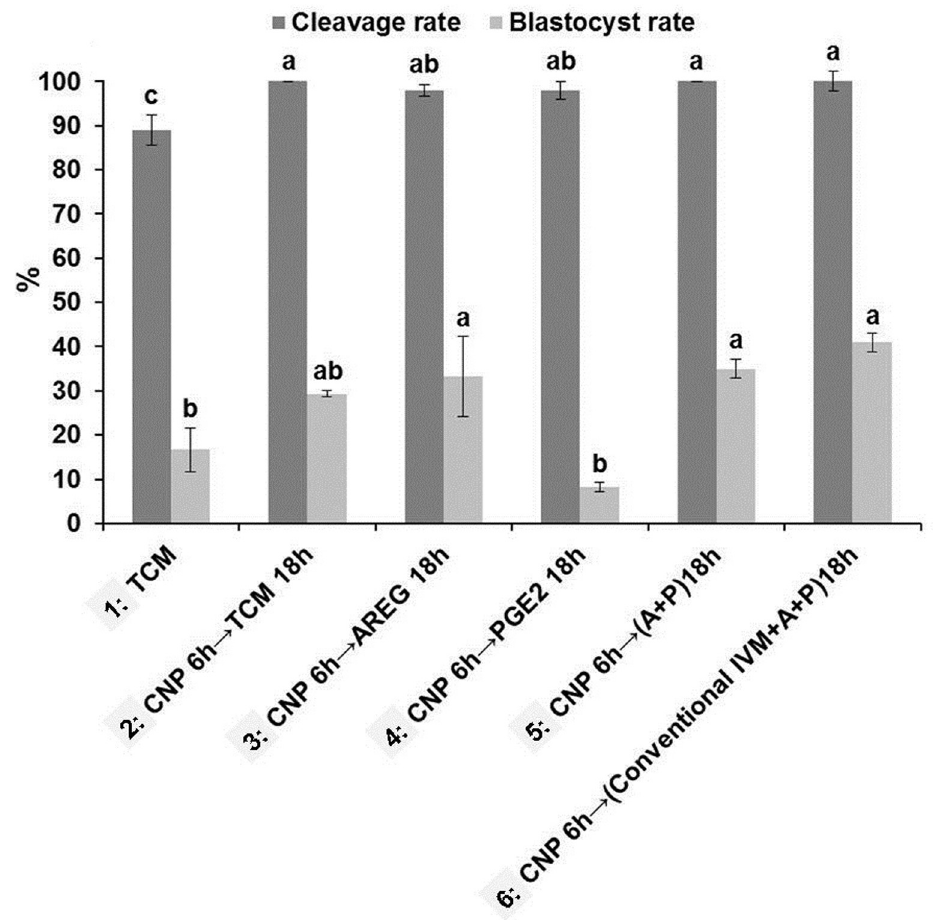
Fig 7. Developmental competence of COCs harvested from small size follicles (2 to � 4 mm) in sheep sequentially exposed to CNP for 6 h, then cultured in TCM+PGE2 and/or AREG for 18 h. Different superscripts demonstrated significant differences (P < 0.05) within columns with the same color. 5 replicates and the minimum number of oocytes in each replicate were 50. TCM: tissue culture medium, CNP: natriuretic peptide type C, AREG: amphiregulin, PGE2: prostaglandin